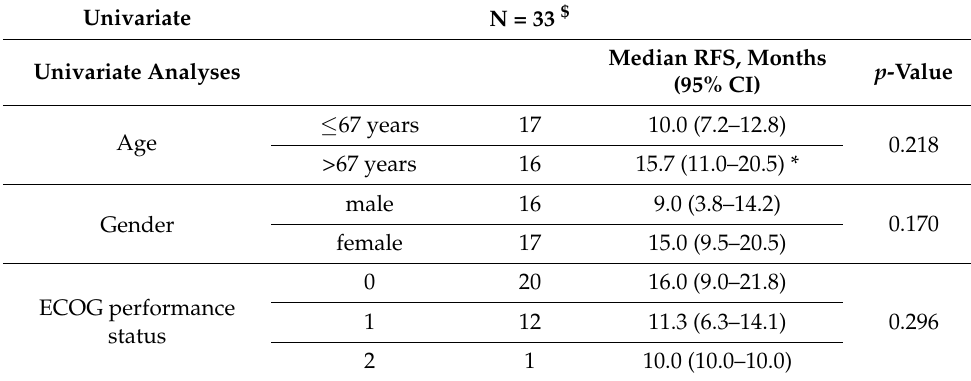
Figure 2. Overall (OS) and recurrence-free survival (RFS) in curative PDAC patients, ( A ) OS influ- enced by CAML positivity at peripheral follow-up blood in curative patients; ( B ) RFS influenced by CAML positivity at peripheral follow-up in curative patients; ( C ) Combined analysis of CAML and CTC detection: impact of parallel follow-up positivity on RFS in curative patients; ( D ) Combined analysis of CAML and CTC detection: impact of each marker combination. Table 2. Univariate analysis on Recurrence-free survival in curative